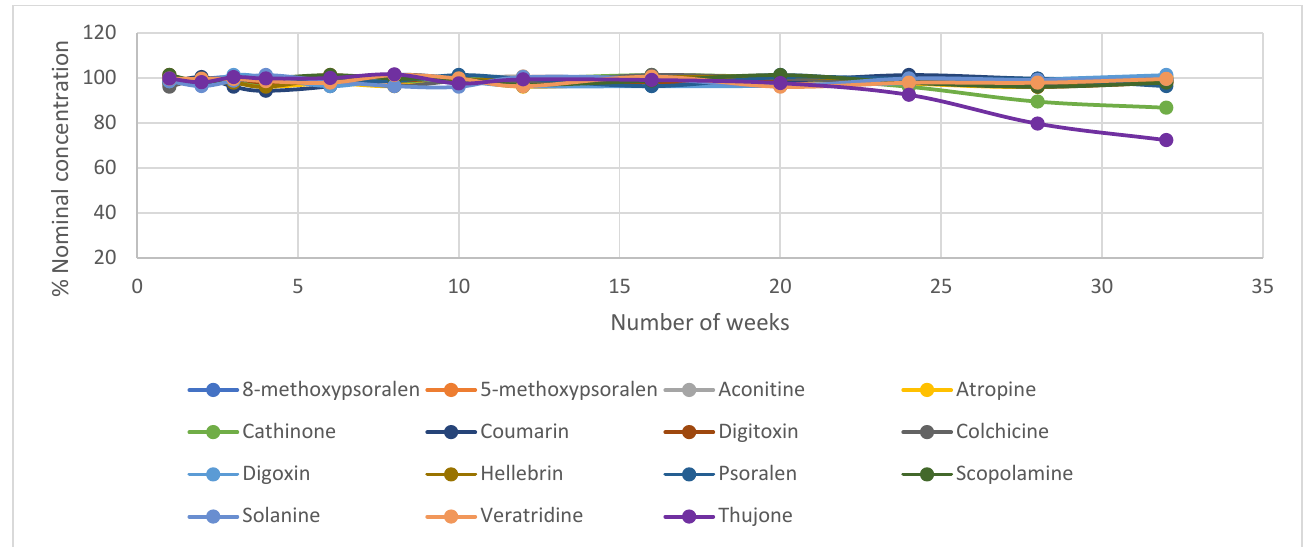
Figure 1. Stability of analytical standards, stored in methanol, at 2–8 °C.